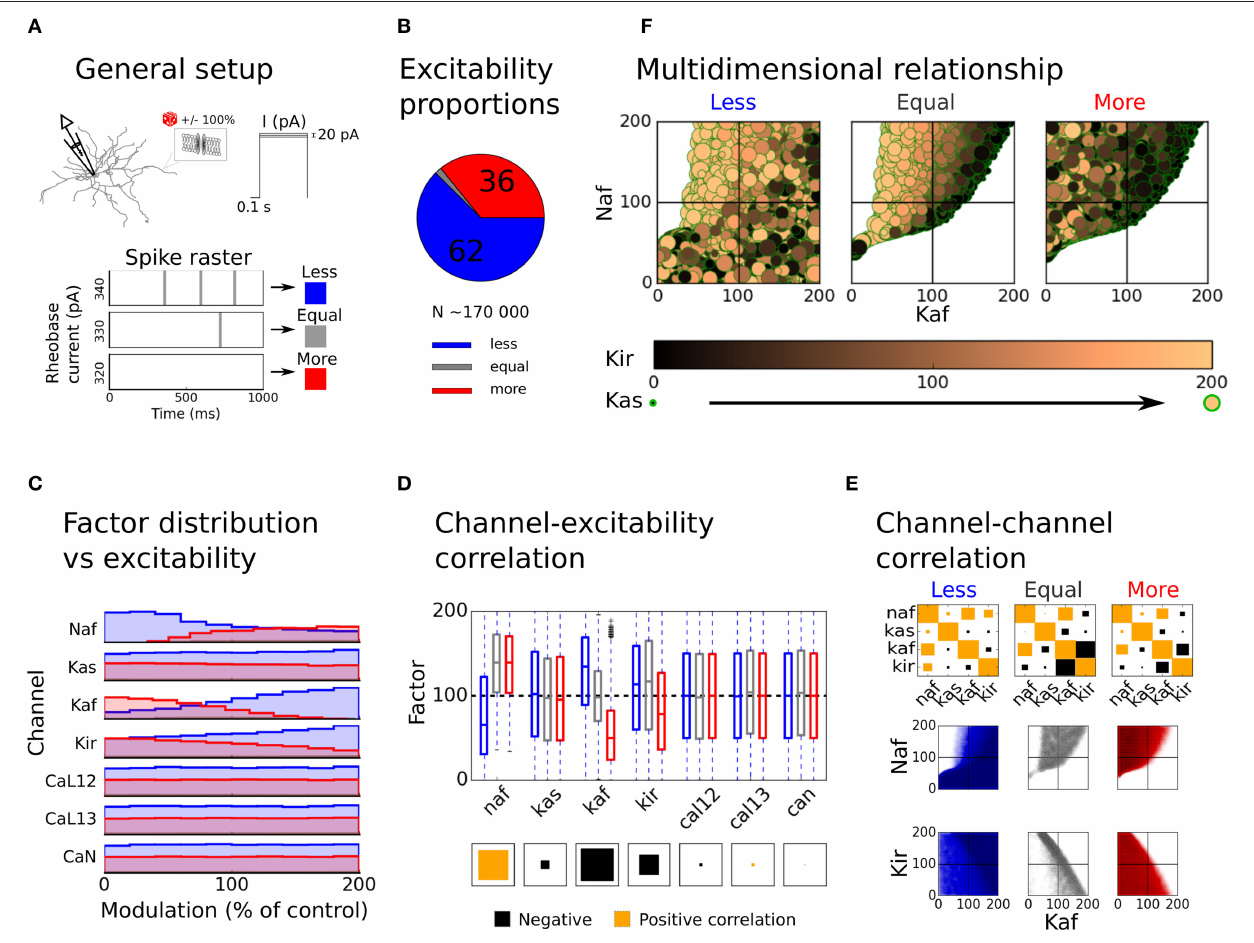
FIGURE 3 | Distribution of modulation factors and overall model excitability. The overall excitability of the uniformly distributed sample set is compared to the unmodulated control case and the contribution of different ion channels to the change in excitability is assessed. In (A) , the general setup of the simulation is illustrated. First a random modulation factor (MF) is drawn for each modulated channel and the conductances are scaled accordingly; then the excitability (in the form or rheobase current) of the new setup is compared to the unmodulated control case and is sorted into groups (More, Equal, and Less). A trial that needs at least 10pA more or less current to spike is sorted into the Less (blue) and More (red) groups, respectively, the rest are categorized as Equal excitable (gray). In (B) , the proportions of simulations in each group is shown. In (C) , the MF distribution over groups is shown. In (D) , the correlation of each channel with excitability is shown as a Hilton diagram. The size of the square is here indicating the magnitude of the correlation while the color of the square shows if the correlation is positive (orange) or negative (black). In (E) , the channel-channel correlations as well as pair vice scatter plots are shown for the potassium and sodium channels. In (F) , information of all modulated potassium and sodium channels are shown as a function of excitability group. The x and y axes, the color and the size of the dots here shows the modulation factors of the Kaf, Naf, Kir, and Kas channels,